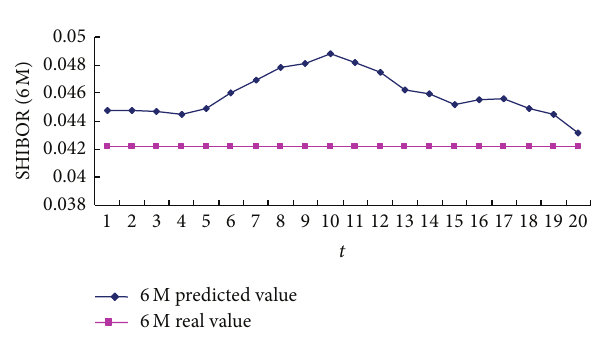
Figure 6: Six-month SHIBOR forecast figure.